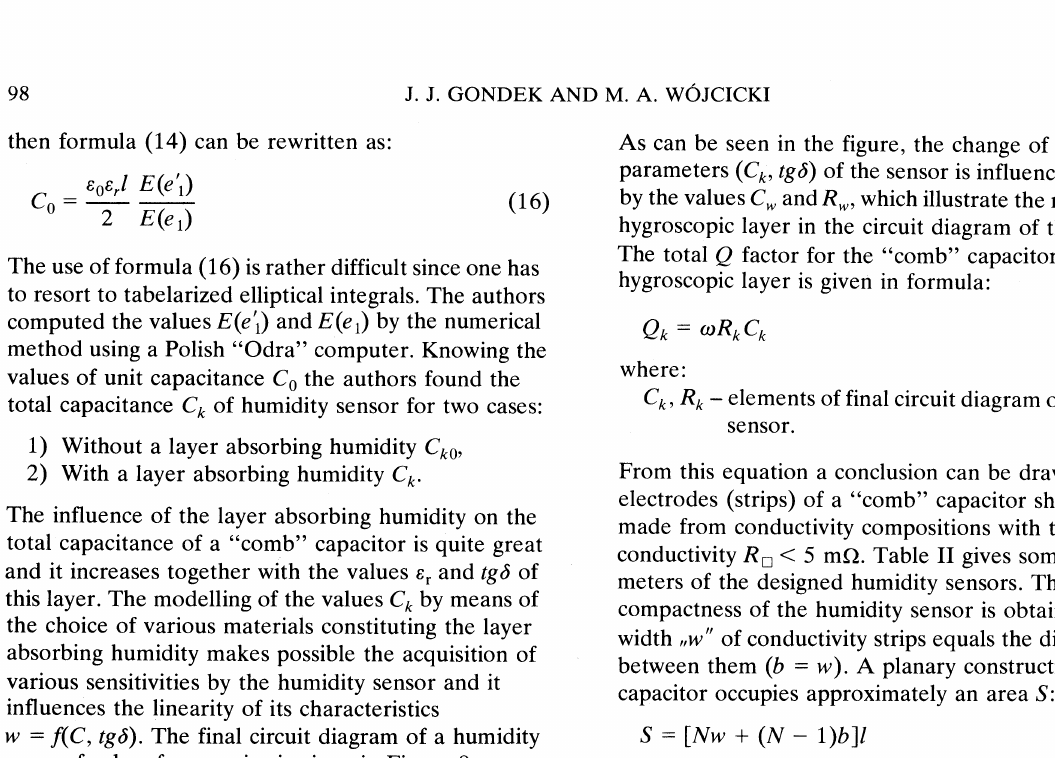
FIGURE 9 Electrical network of thick-film humidity